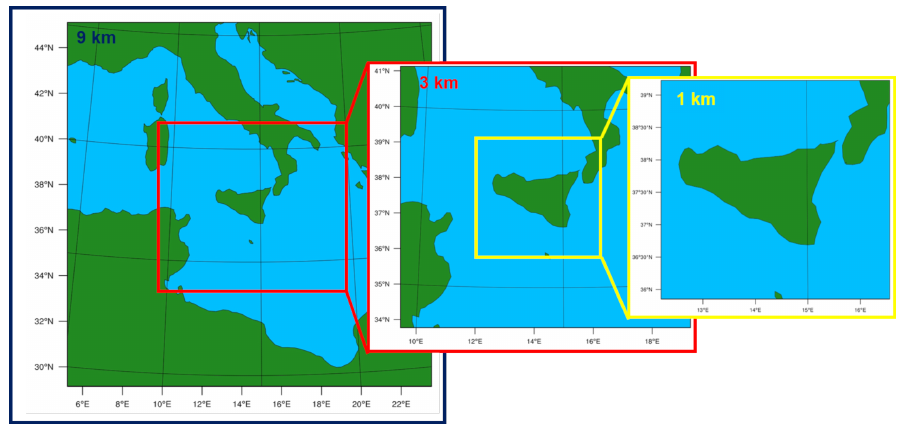
Figure 4. Representation of the nested domains performed in this work. Starting from a parent domain with a resolution of 9 km ( left ), a nested domain of 3 km has been built ( center ) which, in turn, has been used to obtain the final domain of 1 km ( right ).